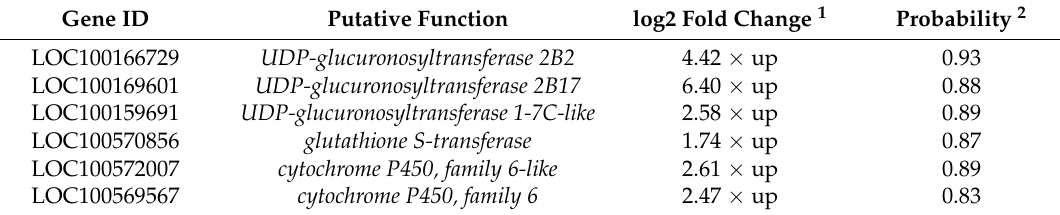
Table 2. Selected related genes differentially expressed between the Medicago host race and Pisum host